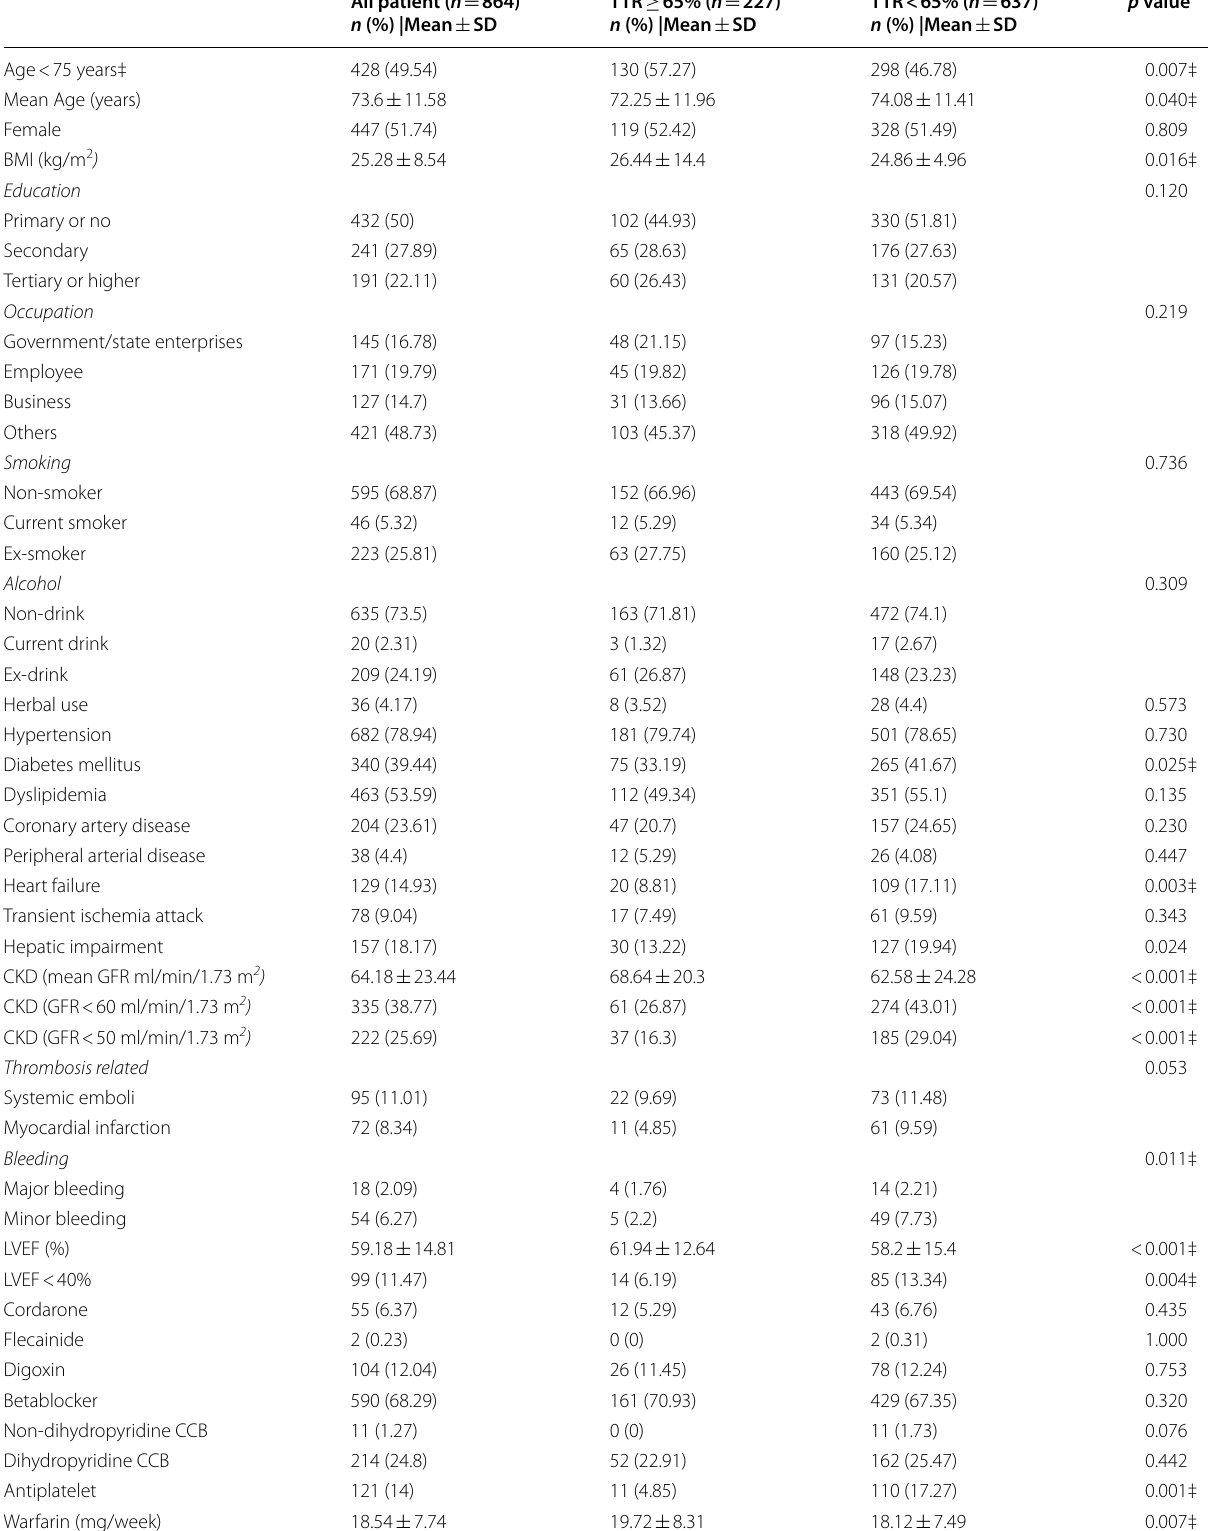
Table 1 Baseline